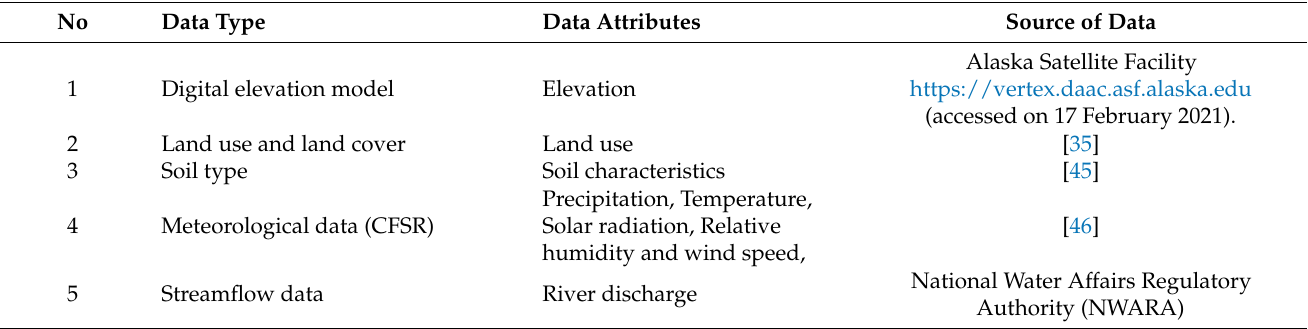
Table 1. Key input data used in the SWAT